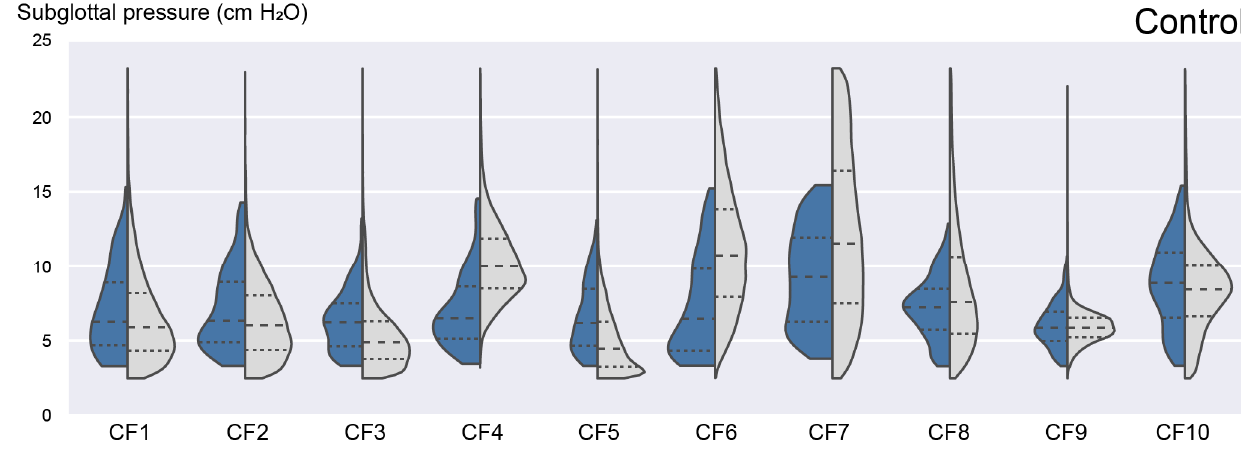
Figure A2. Split-violin plots comparing laboratory (left distribution) and ambulatory (right distri- bution) estimates of Ps for each vocally typical participant. References 1.